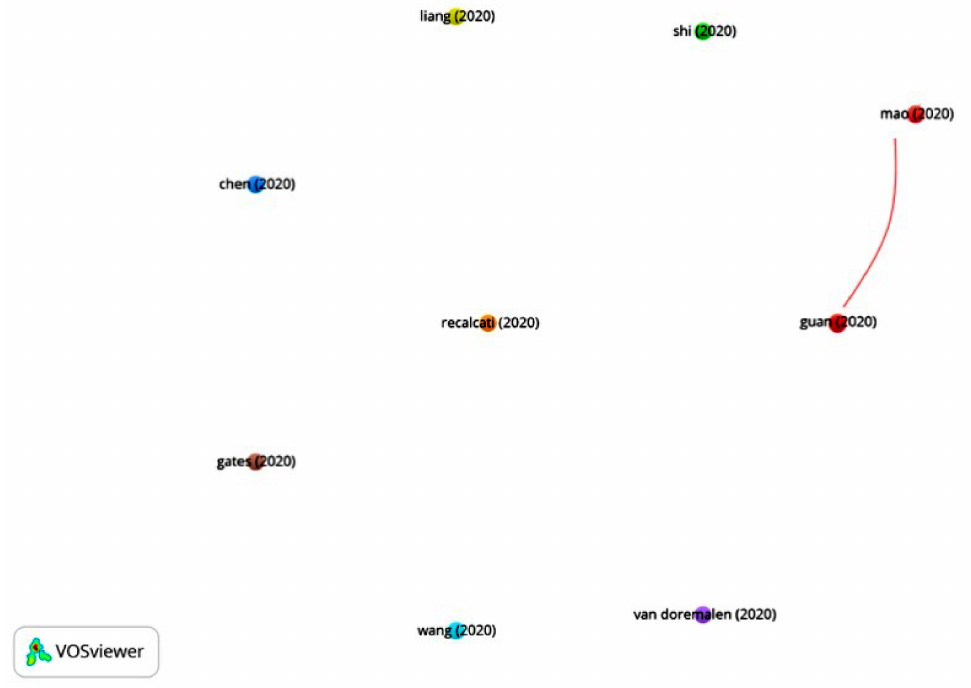
Figure 16. Similarities between the nine main